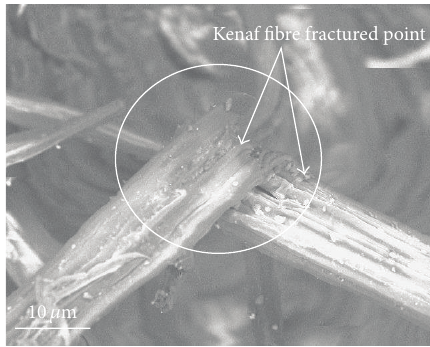
Figure 14: SEM micrograph shows fibre fracture after three-point bending test.